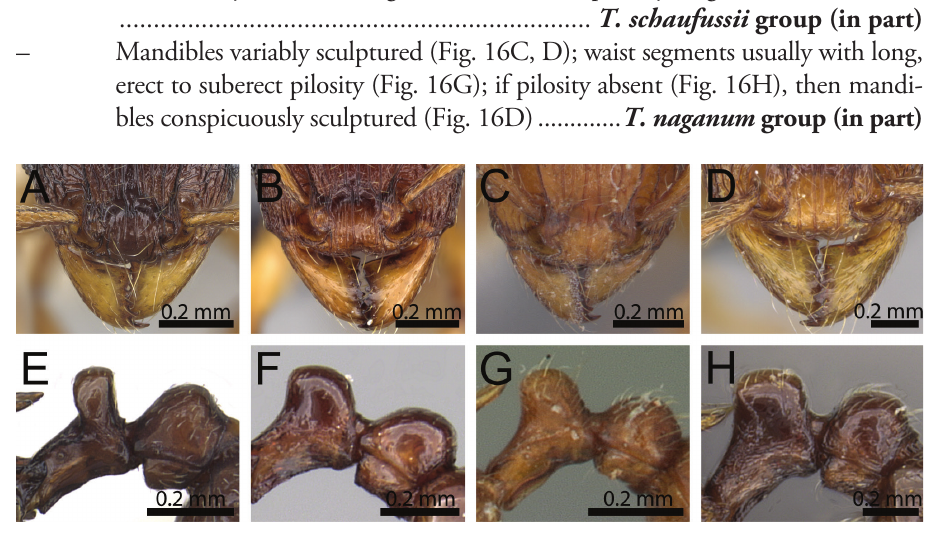
Figure 16. Anterior head in dorsal view and waist segments in profile. A, E T. camelliae (CASENT0247496) B, F T. myrmidon (CASENT0028635) C, G T. naganum (CASENT0102345) D, H T. dalek (CASENT0038402). 17 Antennal scrobes very well developed and distinctly impressed with sharply de- fined posterior and ventral margins; scrobes with very conspicuous median lon- gitudinal scrobal carina, carina always ending between posterior eye margin and posterior margin of scrobe (Fig. 17A, C); petiolar node in dorsal view always noticeably broader than long (Fig. 17B), and in profile with more or less rounded antero- and posterodorsal margins (Fig. 17C); dorsal mesosoma with